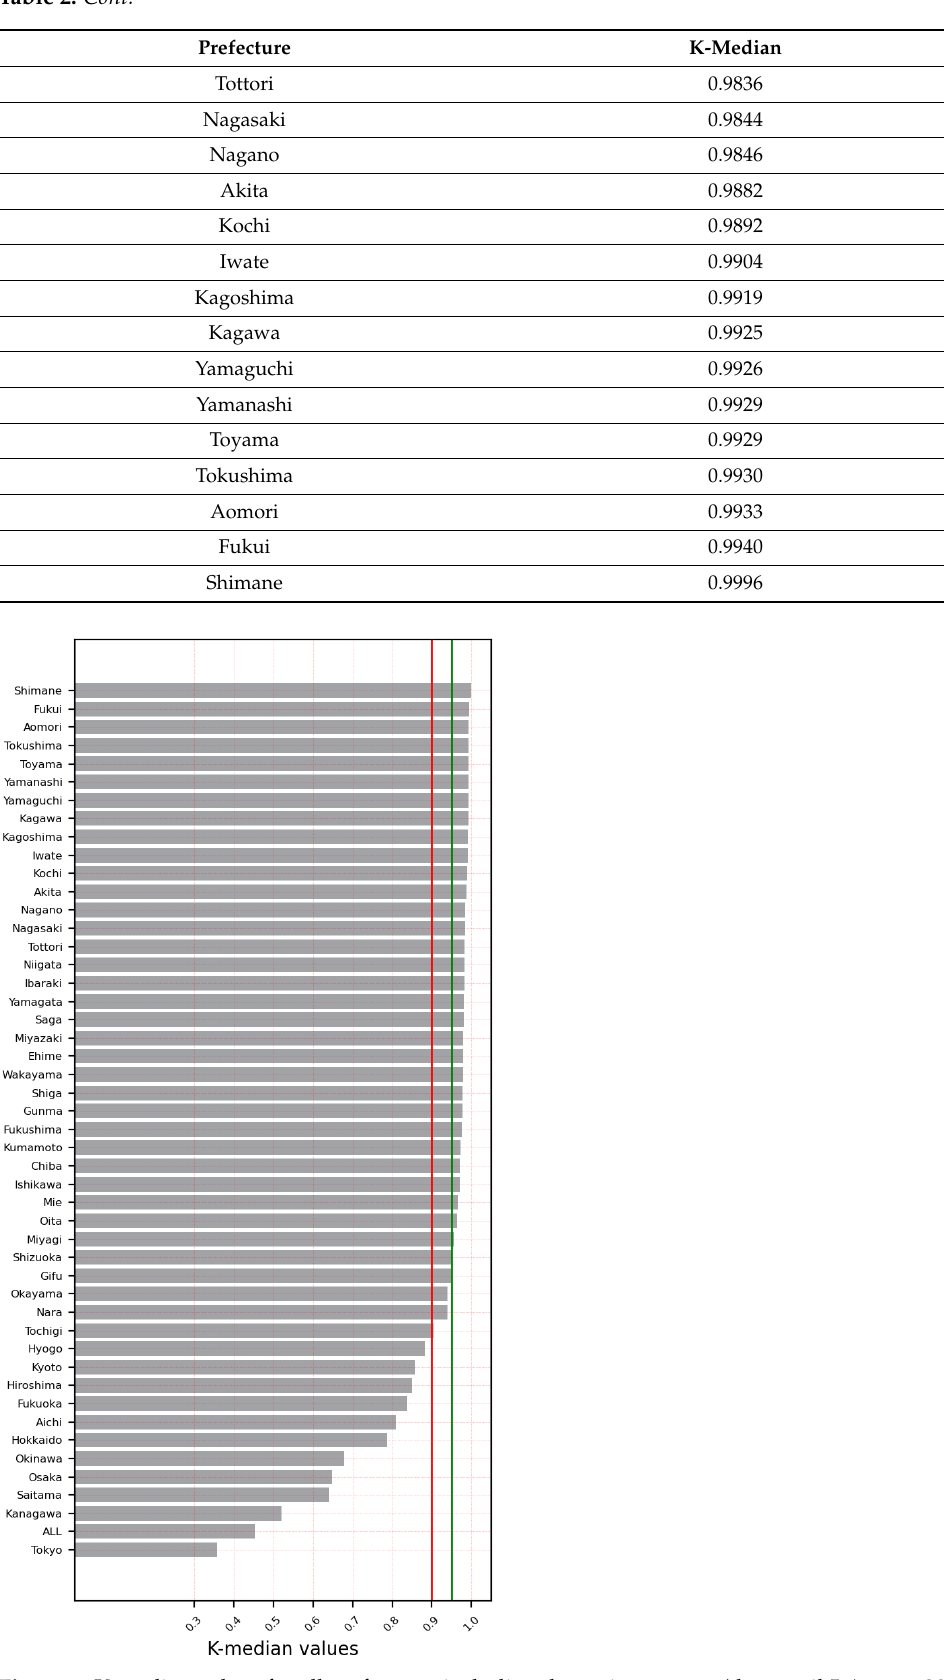
Figure 1. K-median values for all prefectures including the entire country (data until 5 August 2021).